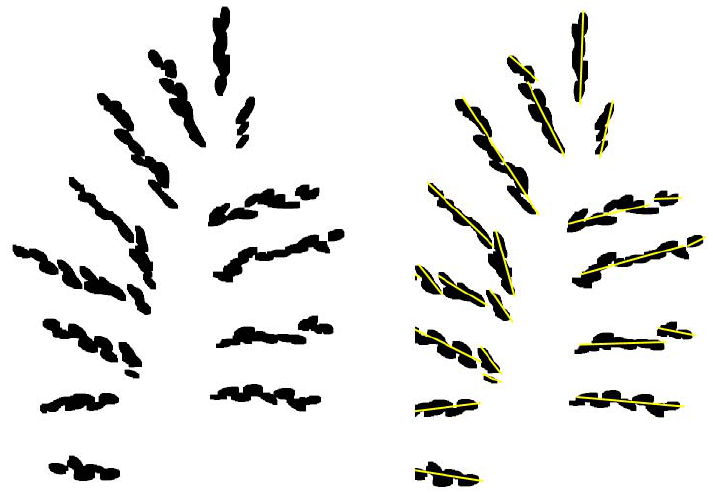
Figure 4 . Main axis of each connected region. Figure 4. Main axis of each connected